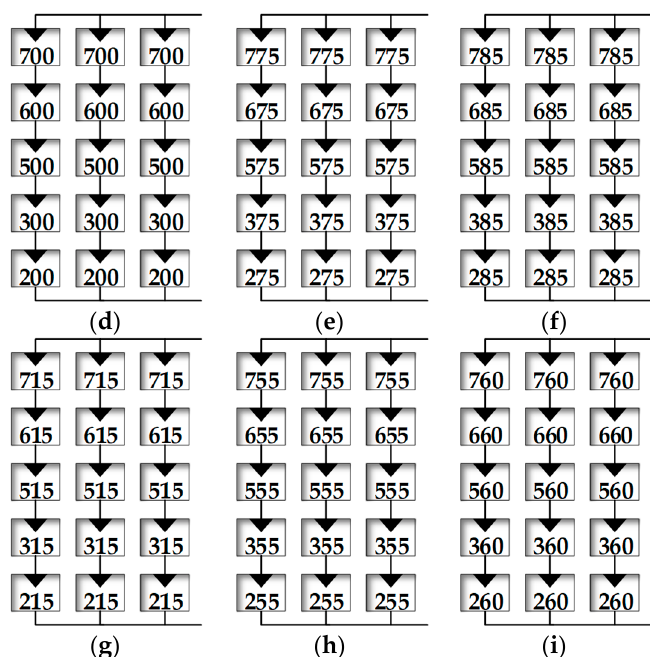
Figure 6. The distribution of incident solar irradiation in W/m 2 over each PV module of the PV array for: ( a ) shading pattern 1, ( b ) shading pattern 2, ( c ) shading pattern 3, ( d ) shading pattern 4, ( e ) shading pattern 5, ( f ) shading pattern 6, ( g ) shading pattern 7, ( h ) shading pattern 8 and ( i ) shading pattern 9.